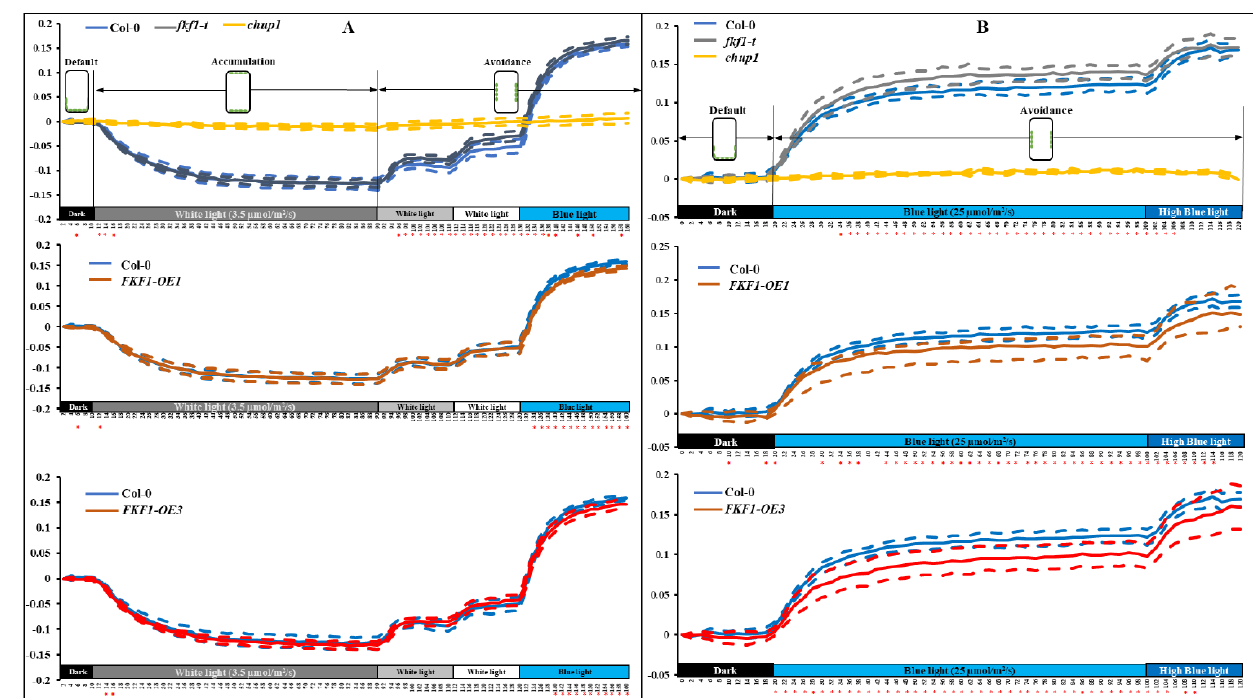
Figure 4. Chloroplast relocation studies using red-light transmittance assay under various light conditions . A red-light transmittance assay was performed to investigate the photorelocation of chloroplasts under various light conditions. ( A ) Chloroplast movement in Col-0, chup1, fkf1-t , and FKF1 OE lines in response to sequential treatments of increasing fluence rates of white light and monochromatic blue light. Red-light transmittance was measured for 10 min in dark adapted leaves to establish a baseline, followed by a sequential 80 min treatment of 3.5 µmol/s/m 2 white light, 20 min treatment of 50 µmol/s/m 2 white light, 20 min treatment of 100 µmol/m 2 /s white light, and finally, 30 min treatment of 25 µmol/m 2 /s monochromatic blue light. Red-light transmittance was recorded every 2 min. ( B ) Chloroplast movement in the Col-0, chup1, fkf1-t , and FKF1 OE lines in response to sequential treatments of increasing fluence rates of monochromatic blue light. Red-light transmittance was measured for 20 min in dark adapted leaves to establish a baseline, followed by a sequential 80 min treatment of 25 µmol/m 2 /s monochromatic blue light, and 20 min treatment of 60 µmol/m 2 /s monochromatic blue light. Red-light transmittance was recorded every 2 min. The data are an average of red-light transmittance changes from 8 independent leaves collected from 8 different plants. Dashed lines represent S.D. ( n = 8). Welch’s t test was used to test the difference between the means from two groups. Statistically significant differences between the Col-0 and any other Arabidopsis lines are labeled with * ( p < 0.05). The diagram shows the expected positions of chloroplasts under different light conditions in Col-0. Y-axes : Δ red-light transmittance; X-axes: time in min.